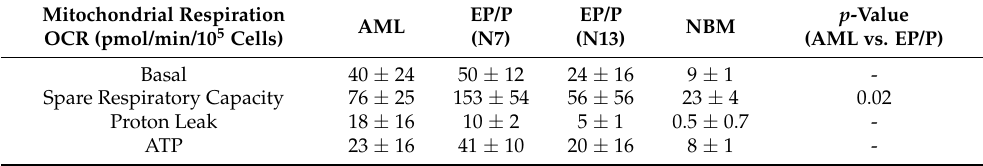
Table 3. Mitochondrial respiration values in AML blasts and normal hematopoietic cells.